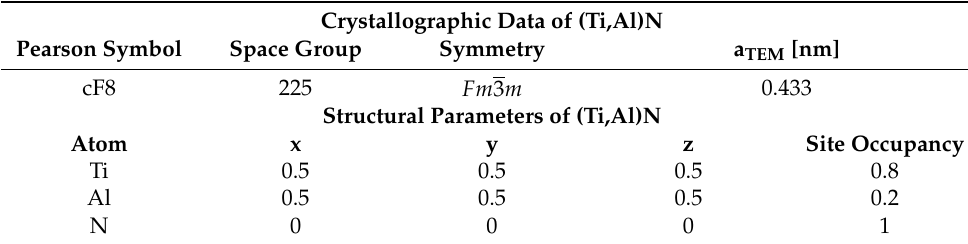
Figure 4. Electron diffraction pattern of (Ti,Al)N and corresponding modeled crystal structure. Table 2. Crystallographic data and structural parameters of (Ti,Al)N.